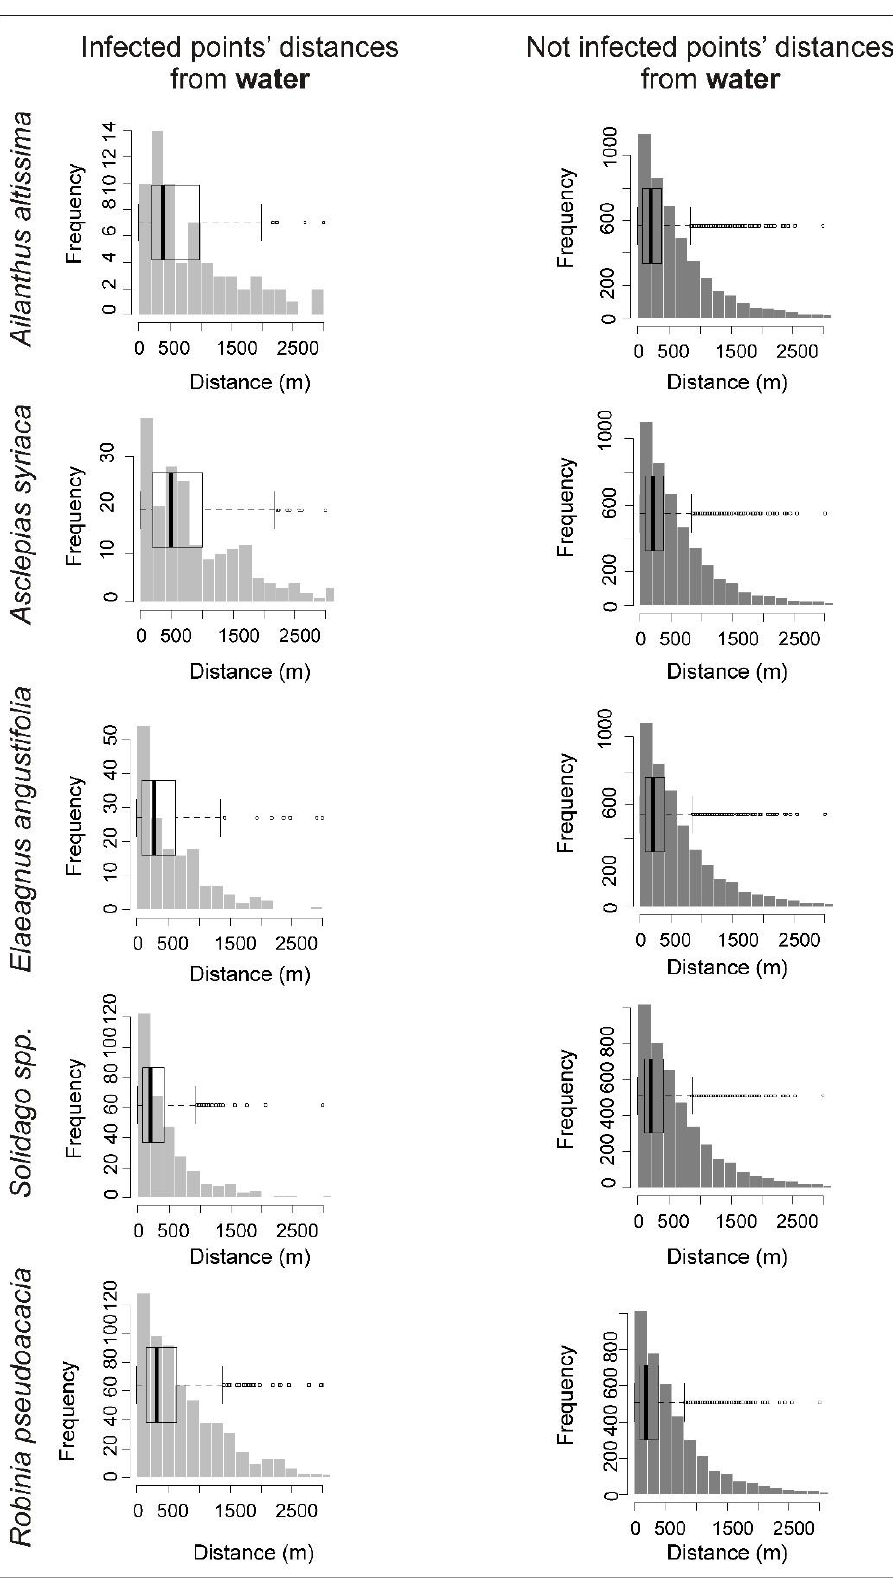
Figure A3. Histogram and boxplots of infected and not infected points’ distances fro m water.